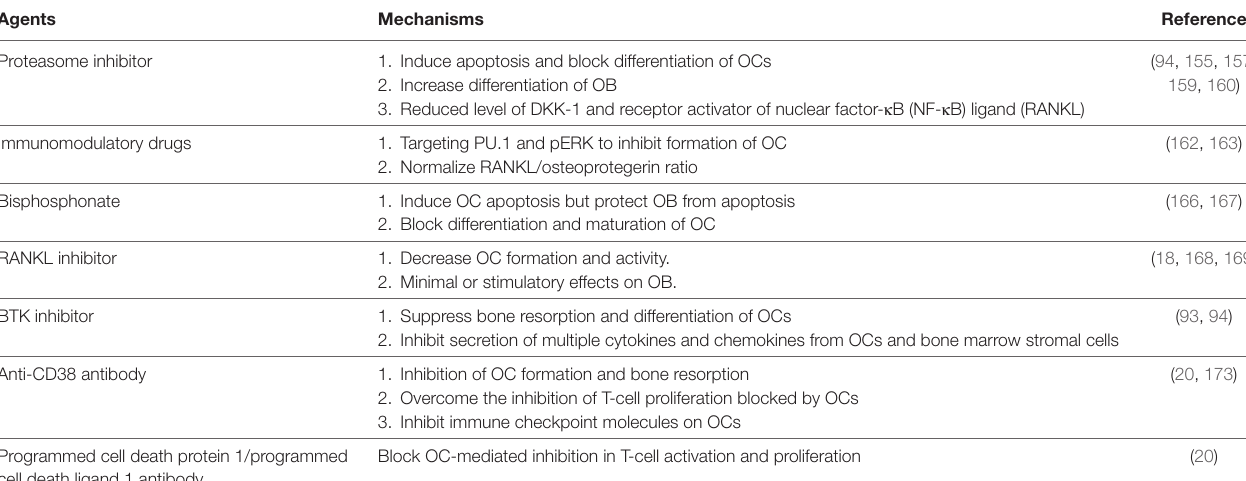
TABLe 2 | Summary of therapeutic agents targeting osteoclasts (OCs) and other cells associated with multiple myeloma bone disease.